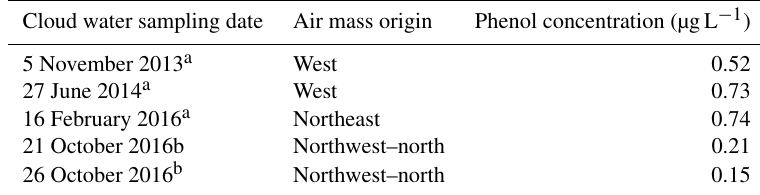
Table 1. Phenol concentrations measured by GC-MS in the five cloud waters sampled at the PUY station.